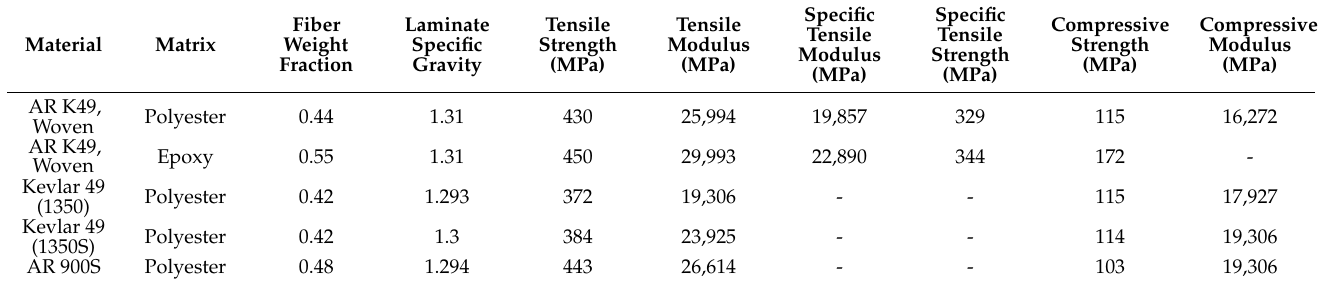
Table 1. Properties of Aramid/Kevlar composites [37,38,42].